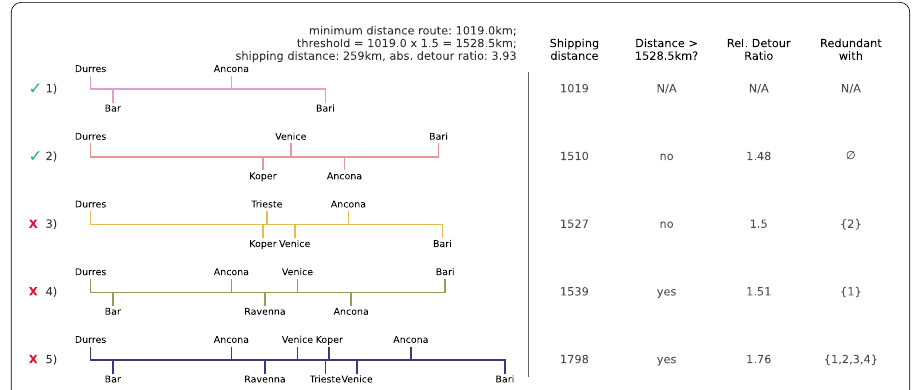
Figure 3 Example of our approach to filtering minimum-route paths. Paths 1 and 2 are kept because their shipping distances are not longer than 150% of the shortest distance, nor are they redundant with any of the other paths. Paths 3, 4, and 5 are all redundant with at least one other path, and paths 4 and 5 are additionally filtered based on their shipping distance. In this example, none of the paths would be filtered based on the detour ratio method, since the absolute detour ratio (3.93) is larger than all of the relative detour